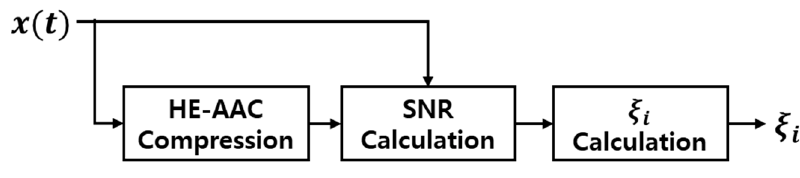
Figure 5. Scale factor ξ i calculation.